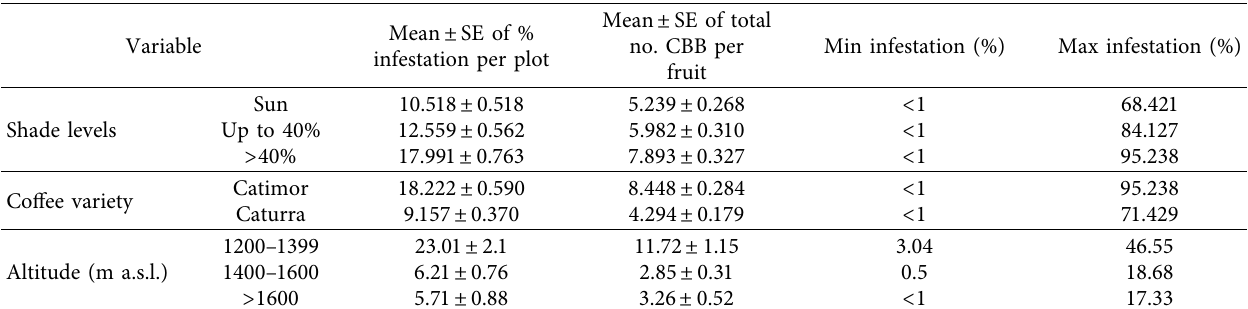
Table 3: Mean ± standard error (SE) of infestation and the adult population of CBB per fruit according to the shade levels and cofee variety. Data from all farms and sampling dates combined.